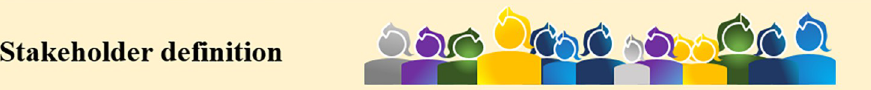
Fig 1. What is a stakeholder and who belongs to it? Definition of a stakeholder